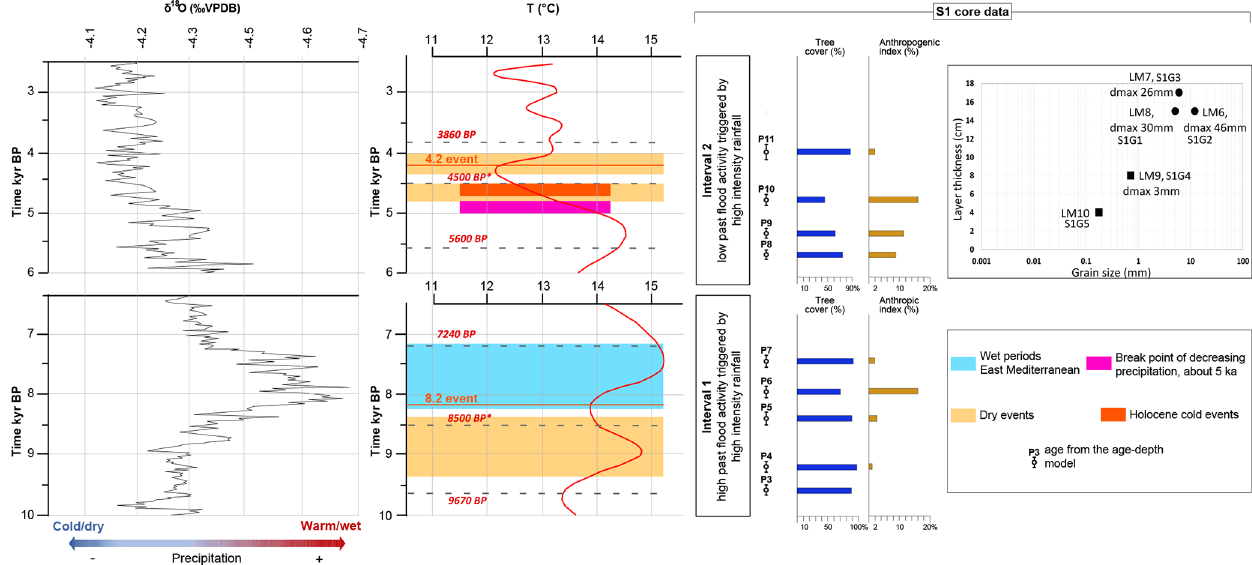
Figure 10. Sedimentological and palynological features of two key stratigraphic intervals (Intervals 1 and 2) from the reference core S1. These features are compared with the most relevant paleoclimate data available from the literature for the area of interest (for references, please see Fig. 7). The anthropogenic index (AI) has been calculated as (anthropogenic indicator / tree percentage) · 100 following Accorsi et al. (1999). Asterisks point to samples containing coprophilous fungi and other spores like Sporormiella , Dicrocoelium and Ascaris . Core S1 sample ages derive from the age–depth model reported in Fig. 6. P samples correspond to the pollen samples; LM labels refer to the lithofacies explained in the text (Sect. 4.1) and in Figs. 3–4; dmax corresponds to the maximum